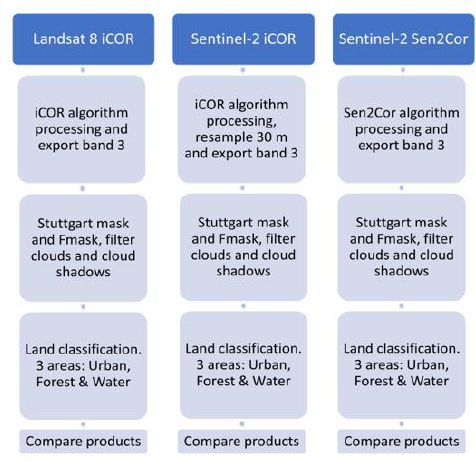
Figure 1. Diagram of data processing